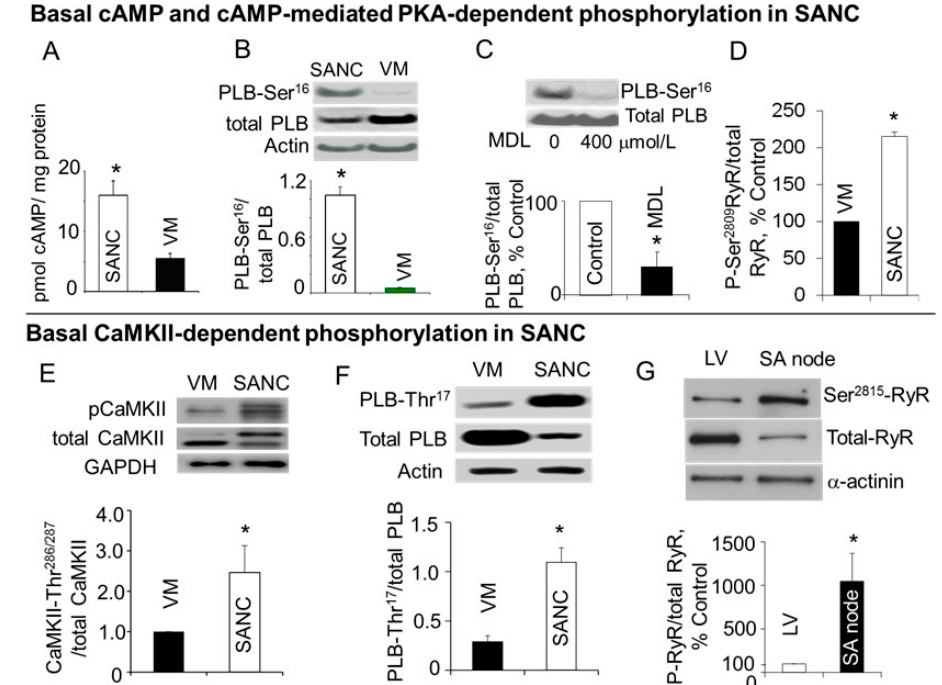
Figure 6. Basal levels of cAMP, PKA- and CaMKII-dependent phosphorylation in rabbit SANC and ventricular myocytes (VM). ( A ) Basal level of cAMP was substantially higher in SANC than in